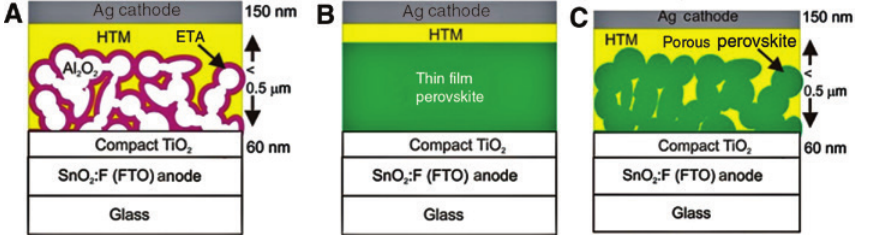
Figure 22: Schematic depiction of (A) meso-superstructured solar cell, (B) thin-film p−i−n perovskite solar cell, and (C) perovskite sensi- tized solar cell. Reprinted with permission from [116]. Copyright 2013 American Chemical Society.